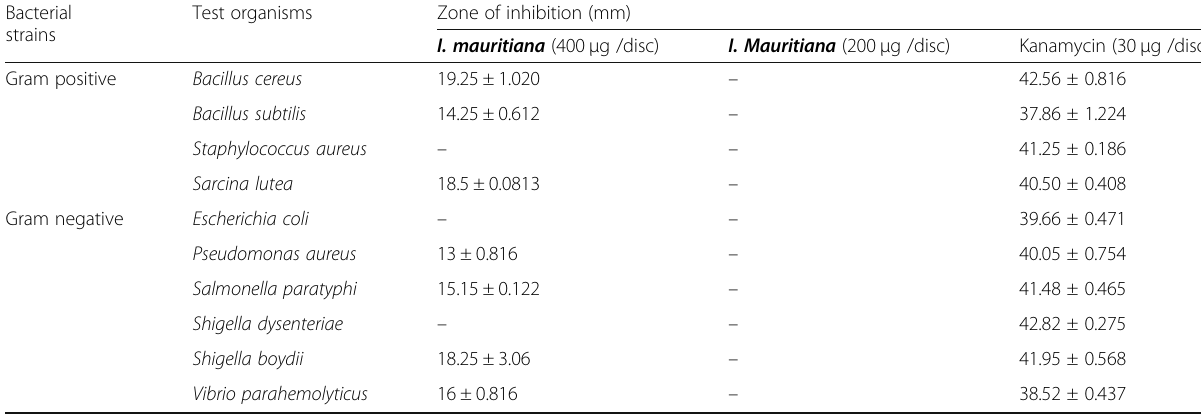
Table 3 Antibacterial activity of I. mauritiana using the disk diffusion method Bacterial Test strains